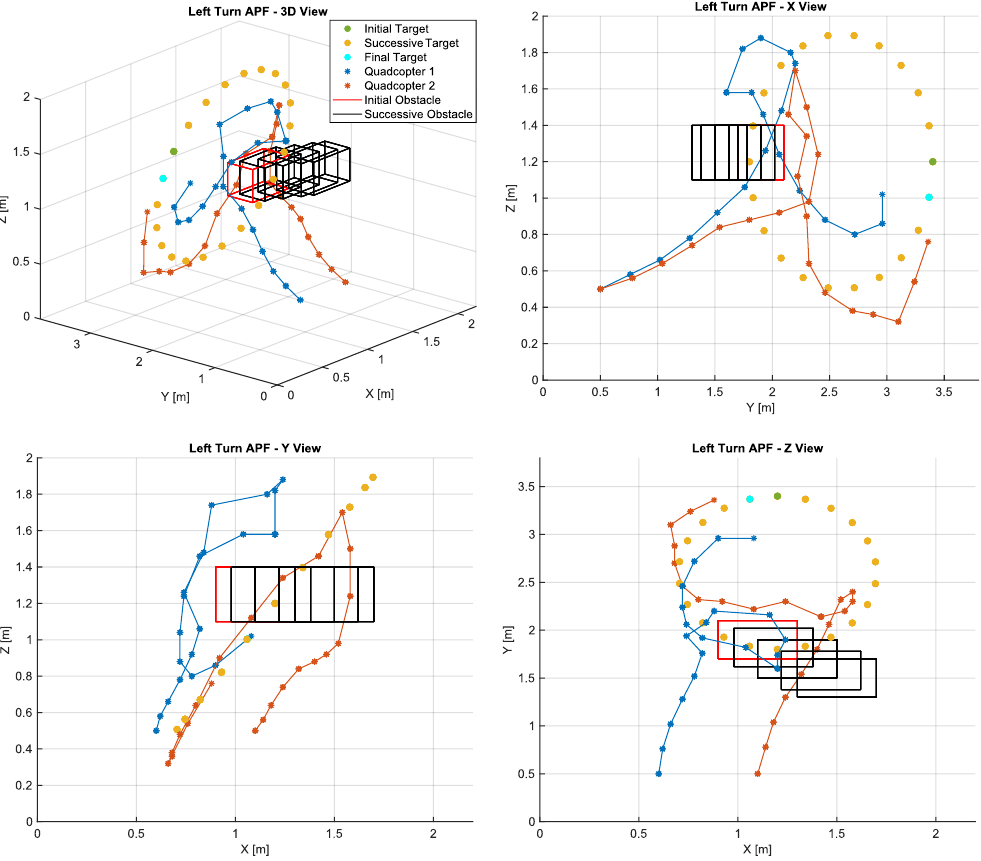
Figure 6. Paths calculated by the LTAPF algorithm.